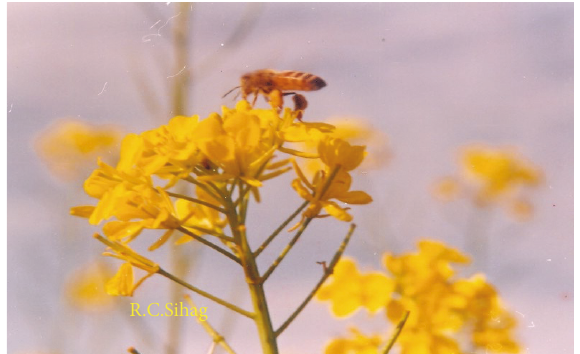
Figure 4: A forager of the European honeybee ( Apis mellifera F.) collecting only pollen from the top/front of the flower of turnip ( Brassica rapa L.)